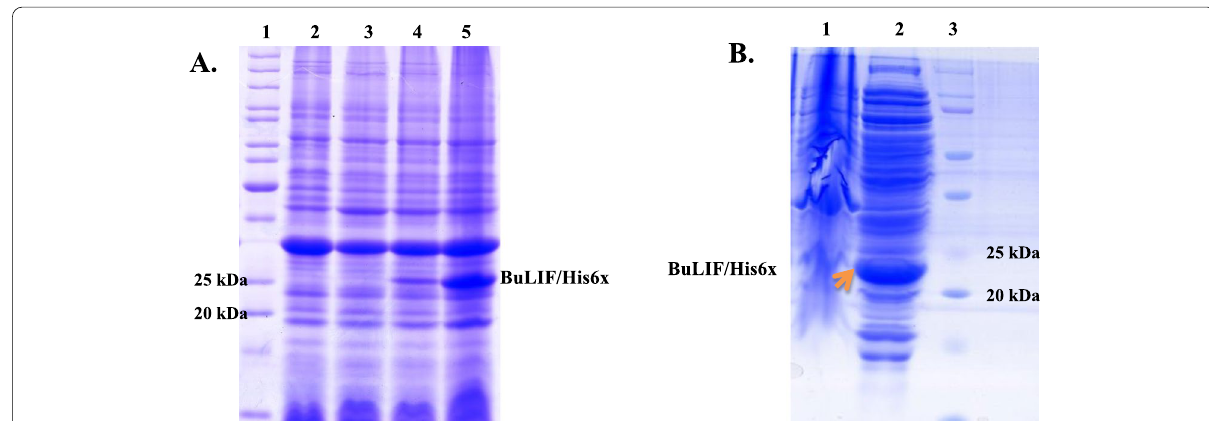
Fig. 2 Expression analysis of recombinant BuLIF in Lemo-21 (DE3), A The transformed Lemo21 (DE3) competent cells containing recombinant construct were induced with 1 mM IPTG at 37 °C.SDS-PAGE analysis showed recombinant protein BuLIF/His6x was expressed at different time interval of 4 h and 12 h. An equal volume of cells were loaded onto lanes 2–5. Lane 1, protein marker; lane 2, total cell protein before IPTG induction and lanes 3, 4, and 5, total cell protein after induction at different time of interval after IPTG induction. The maximum expression of recombinant protein was observed at 12 h. B The soluble and insoluble fractions after cell lysis were observed via SDS-PAGE showed that recombinant BuLIF was expressed mainly in soluble fraction. Lane 1, insoluble fraction; lane 2, soluble fraction; lane 3, protein marker. Arrow represents the soluble fraction of recombinant BuLIF in comparison to un-induced cells after cell lysis